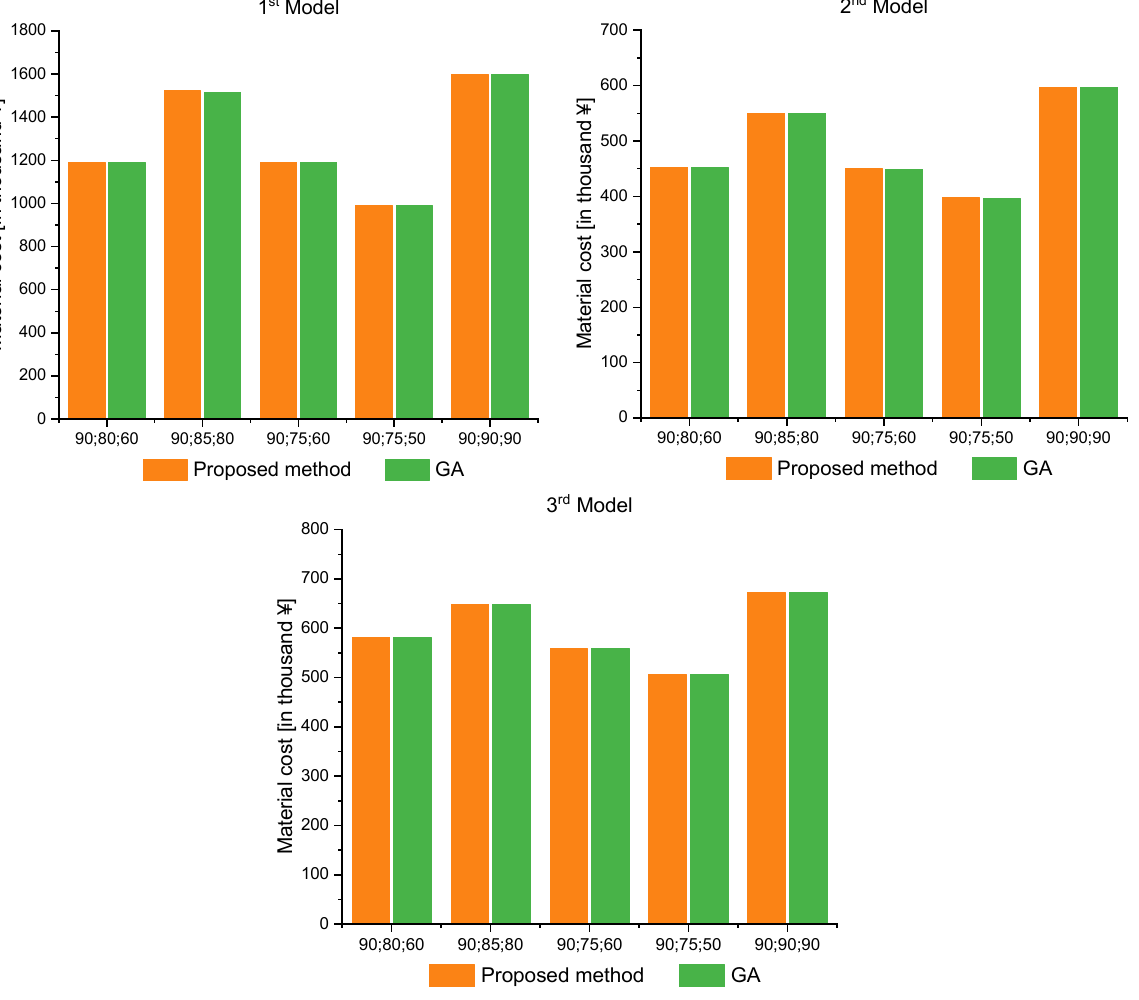
Figure 13. Total material cost of each price variation.